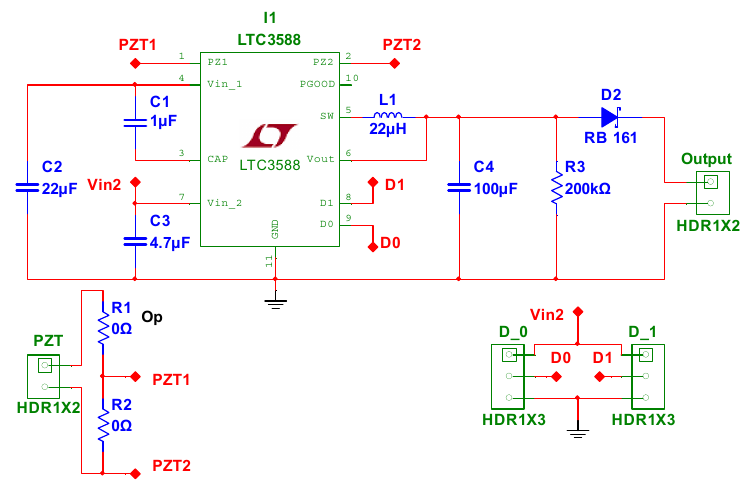
Figure 8. Integrated circuit LTC-3588.